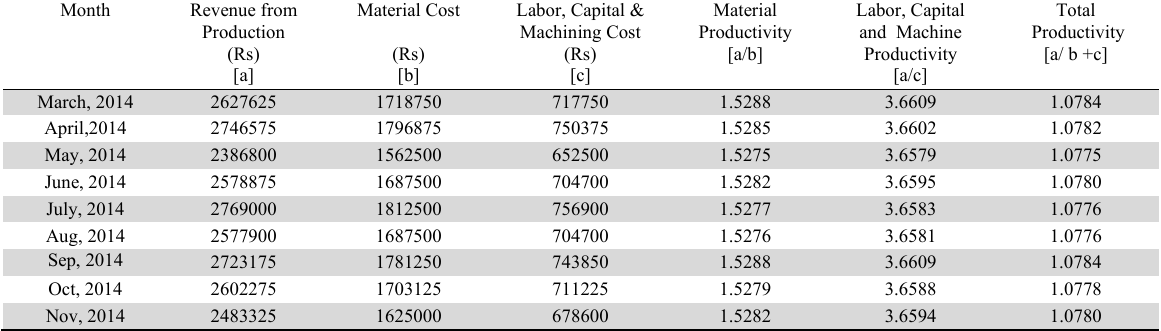
Improved Material, Labor- Capital- Machine and Total Productivity Revenue from